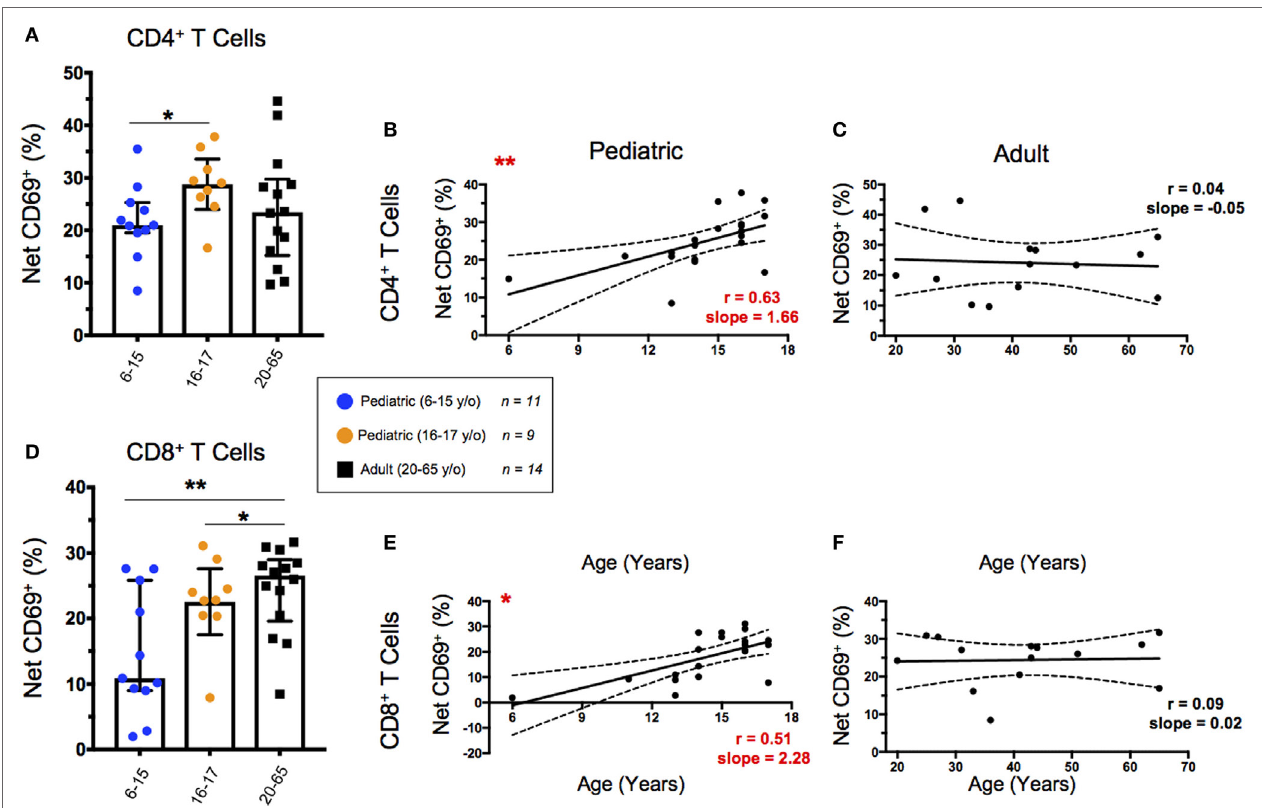
FigUre 2 | CD69 expression following staphylococcal enterotoxin B (SEB) stimulation. Scatter plots showing the percentages of CD69 + in (a) CD4 + and (D) CD8 + T cells. Net CD69 + cells represent the % CD69 + cells in SEB-stimulated cultures minus expression in the corresponding media controls. Populations are shown